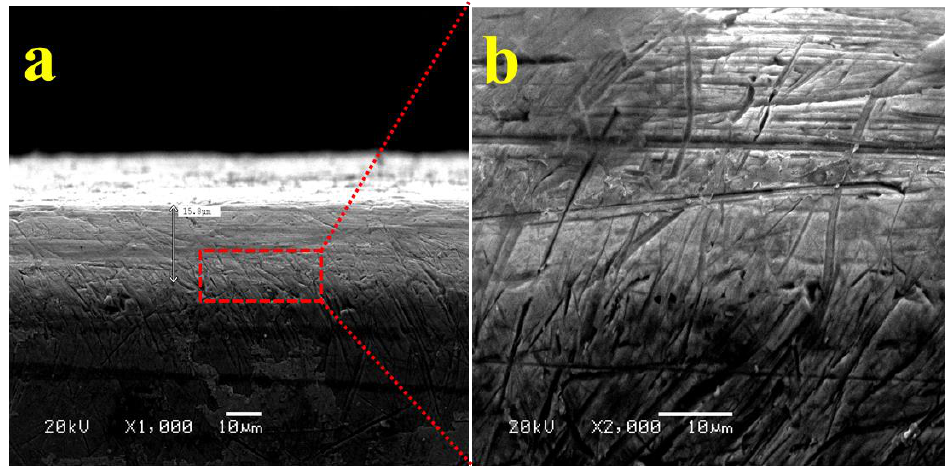
Figure 1. The cross-sectional view ( a ) of a Ni – Co – P/Si 3 N 4 composite coating over a silicon aluminum alloy, ( b ) a higher magnification view of selected area in ( a ).